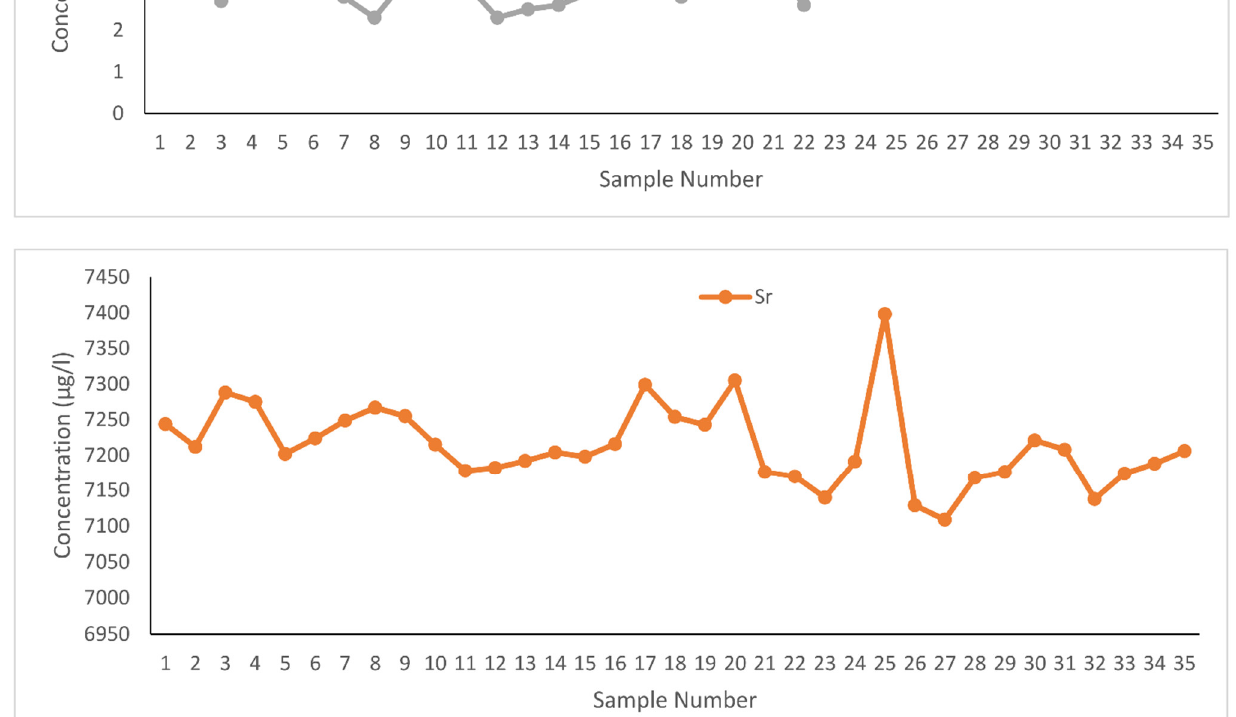
Figure 3. Distribution of Cd, Sb, As, V, and Sr in seawater samples.